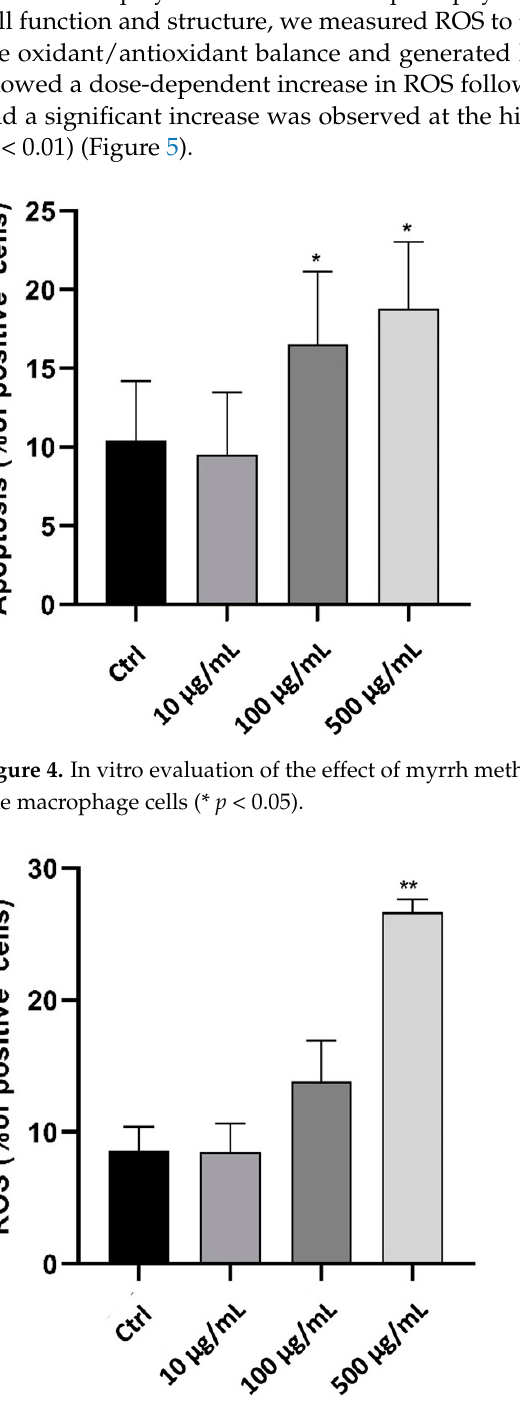
Figure 5. Effect of myrrh methanolic extract on reactive oxygen species production in Thp-1-like macrophage cells. The results demonstrate a dose-dependent increase following 100 µ g treatment, with a significant change observed at 500 µ g treatment (** p < 0.01).